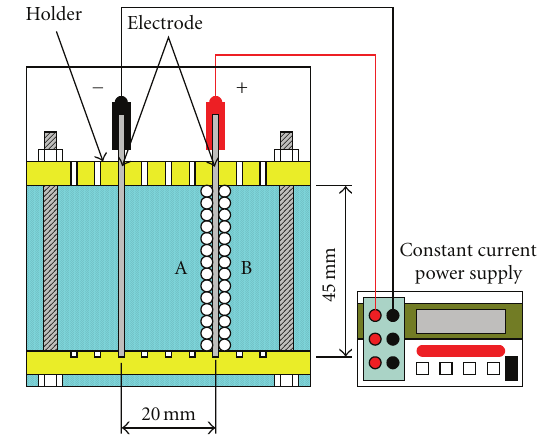
Figure 4: Experimental setup for EPD